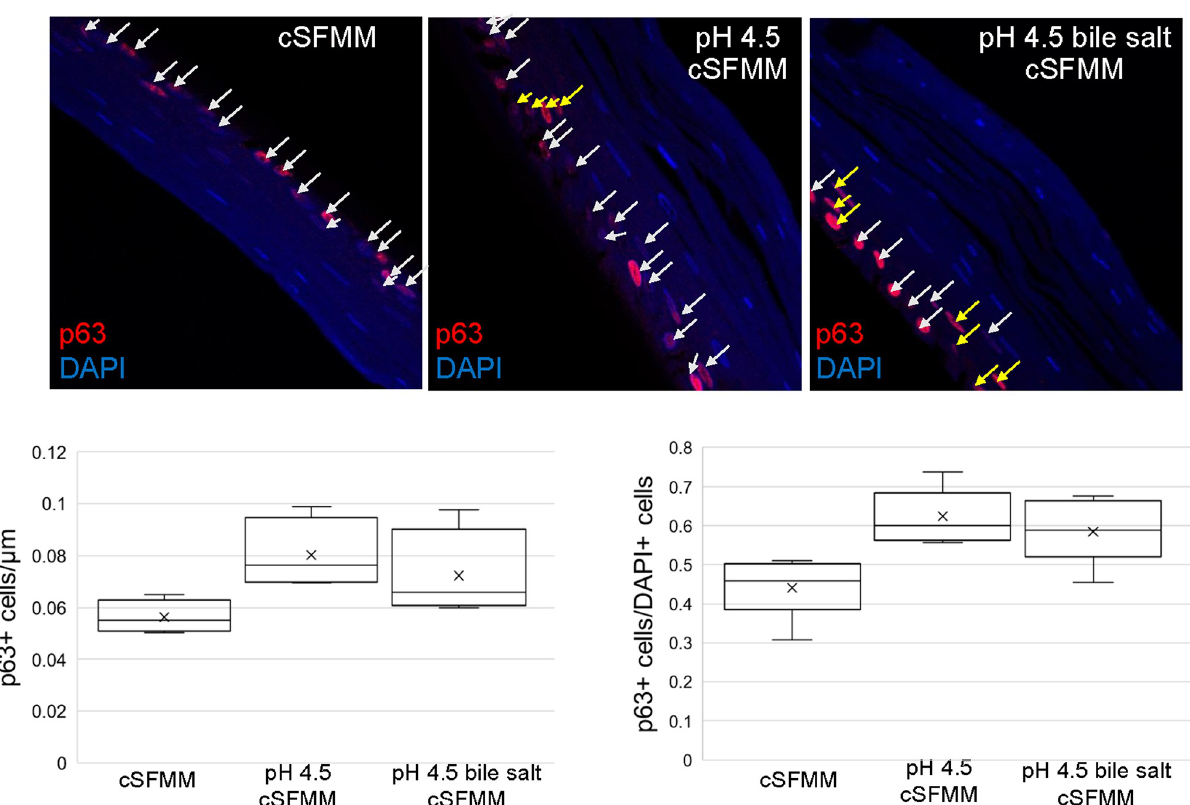
Fig 2. Basal cell marker p63 expression in the squamous epithelium in 3D OTC-ALI in response to conditioned media from untreated, pH 4.5 and pH4.5 bile salt treated HEMFs. p63 (pink/red) immunostaining is shown for the epithelium from 3D-OTC established with conditioned media from untreated, pH 4.5, and pH 4.5 bile salt treated HEMFs. p63 signal is multi-layered in the squamous epithelium established with conditioned media from pH 4.5 and pH 4.5 bile acid treated HEMFs. Arrows point to p63 stained cells and yellow arrows indicate multi-layered cells. Representative images and quantification of three independent, reproducible experiments are shown. Quantification of p63 was done per total length ( μ m) of tissue available for histologic analysis and also per DAPI+ cells. Box and whisker plot of data from three independent experiments is shown (minimum, maximum, lower and upper quartile, and median are shown in the box and whisker plot). Mean values are indicated by X. An increase in p63+ cells/ μ m is observed in the epithelium established with conditioned media from pH 4.5 treated HEMFs (separate box and median) and a trend in increase expression with conditioned media from pH 4.5 bile salt treated HEMFs compared to untreated HEMFs (cSFMM and pH 4.5 bile salt conditioned media boxes overlap, but median of pH 4.5 bile salt conditioned media remains outside of cSFMM box). When p63 quantification is performed per DAPI+ cells, an increase in the number of p63+ cells is observed in the squamous epithelium established with conditioned media from pH 4.5 and from pH 4.5 bile salt treated HEMFs compared to conditioned media untreated HEMFs.